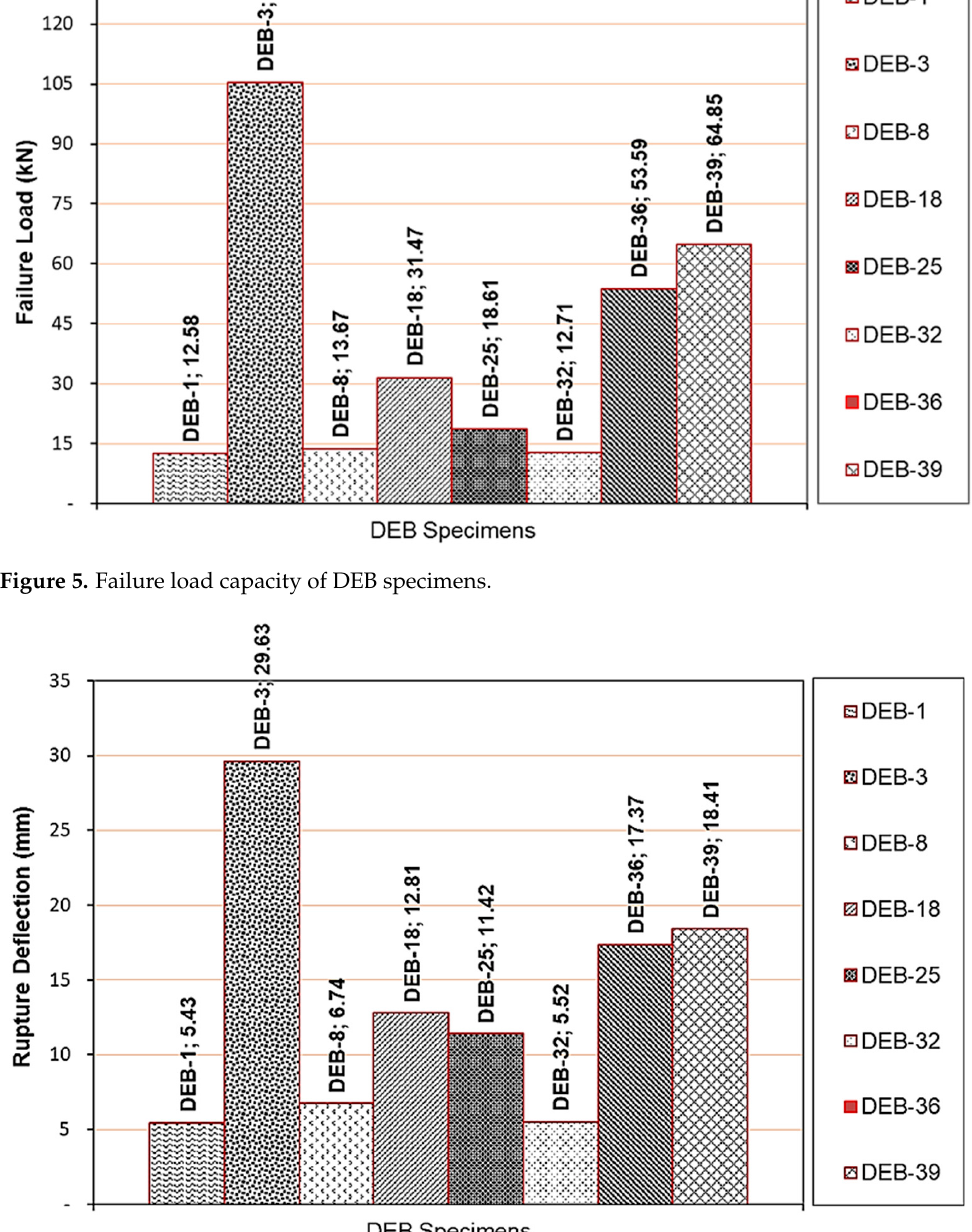
Figure 6. Deflection of DEBs at rupture condition.